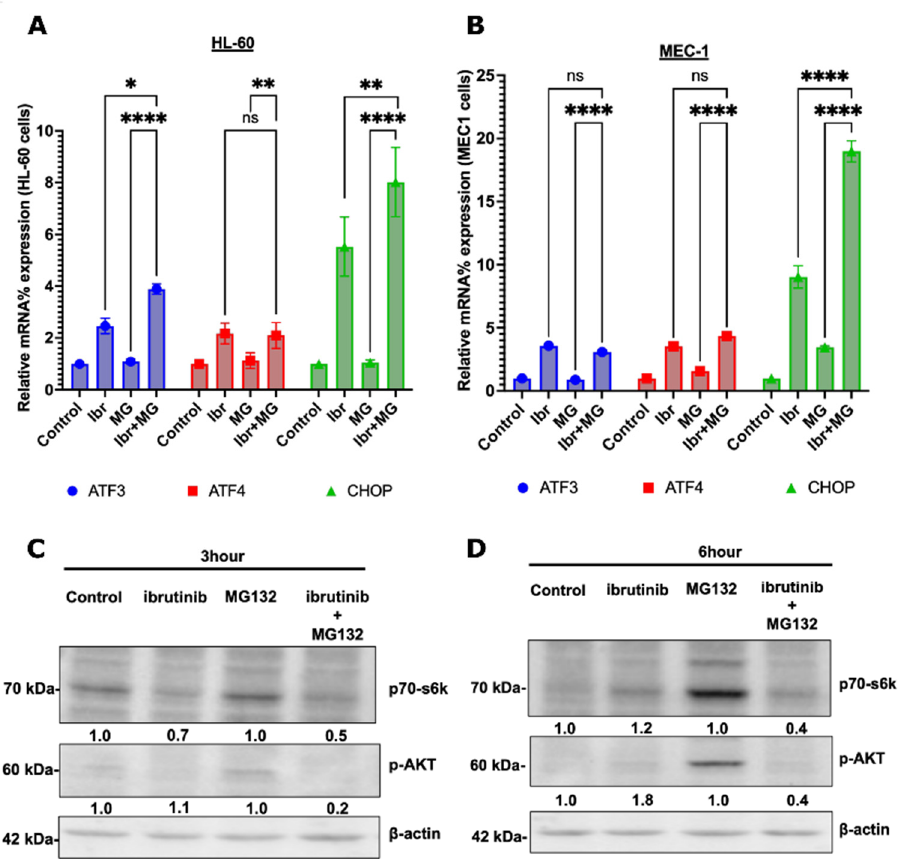
Figure 3. Effects of Ibrutinib and MG132 on UPR and Akt pathways. ( A , B ) Expression of CHOP and ATFs mRNA in response to ibrutinib and MG132 in ( A ) HL-60 and ( B ) MEC1. The cells were incubated for 12 h with ibrutinib or MG132 or their combination, and expression of the indicated species of mRNA was measured by qPCR. The experiment was performed in biological triplicates (n = 3). Statistical analysis was performed using two ‐ way ANOVA. All statistical analyses were performed using Graphpad (v9), and the level of significance was taken as (“ns < 0.1234”, * “ p ” < 0.0332, ** “ p ” < 0.0021”, **** “ p ” < 0.0001), as denoted appropriately on above graphs. ( C ) Effects of MG132 and ibrutinib on phosphorylation of Akt and the mTORC1 substrate p70 S6 kinase (Thr421/Ser424). The cells were incubated with 15 μ M ibrutinib and/or 100nM MG132 for 3 h and ( D ) 6 h. The phosphorylation state of the proteins was assessed by immunoblotting.